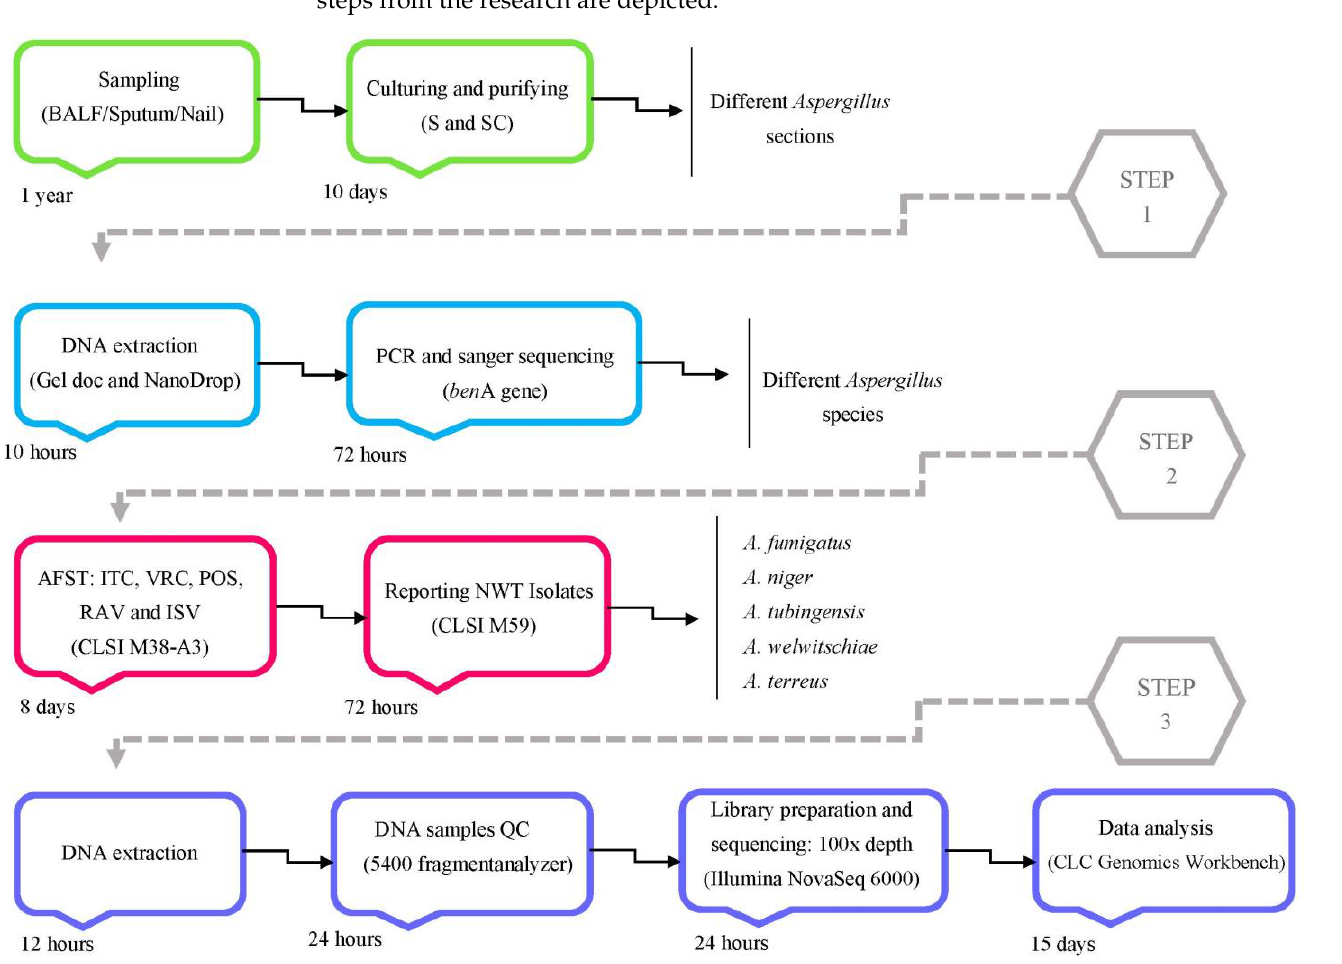
Figure 1. The steps of project implementation, from sample collection to WGS. The estimated time to complete each of the key stages of the project indicates that after the sampling phase, which spans a period of one year, within two months, it is possible to analyze azole-resistant Aspergillus spp. through whole genome sequencing to identify all SNPs in the entire genomic content.